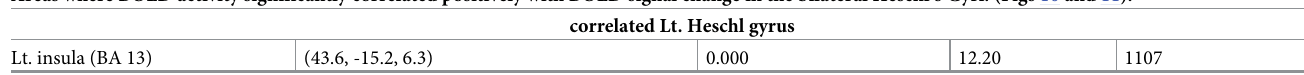
p-value (FWE corrected, cluster level)